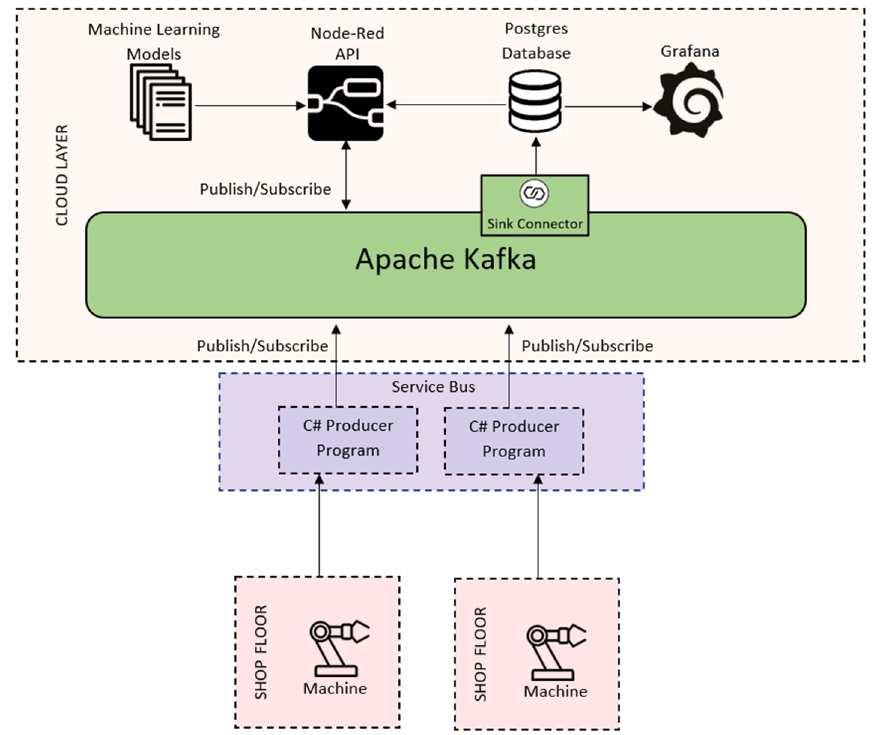
Figure 9. Implementation overview.